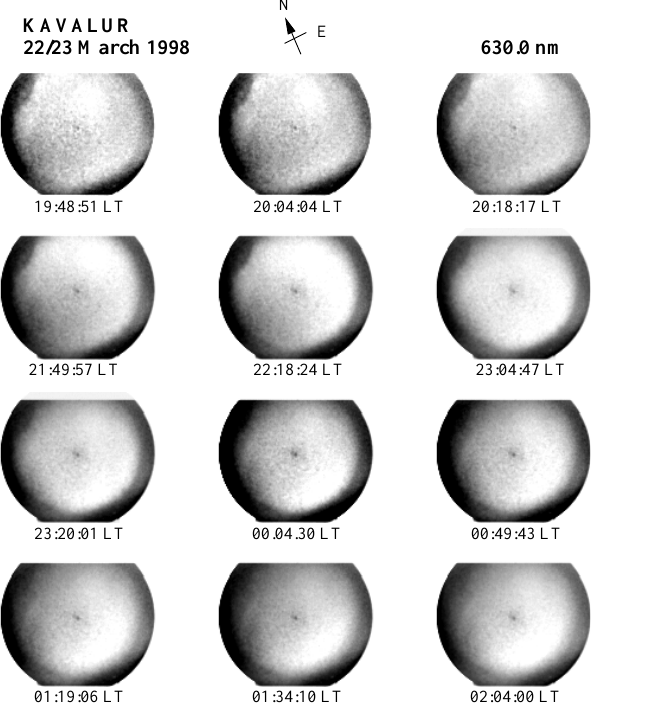
Fig. 12. Plasma enhancements or brightness patterns in the 777.4nm images taken over Kavalur on the night of 22/23 March 1998. The arrow points towards the geomagnetic